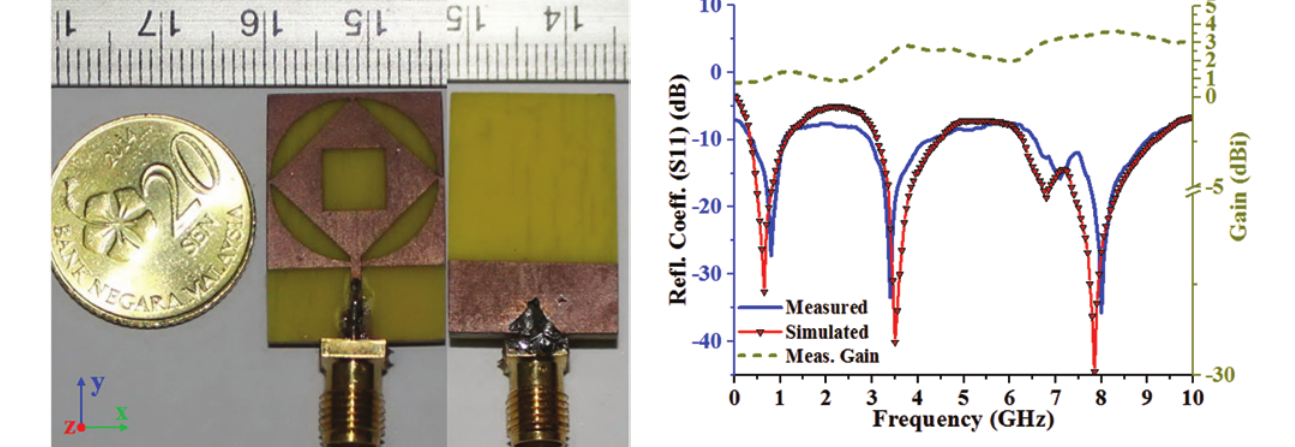
Figure 5: Measured and simulated reflection coefficients and meas- ured gain against